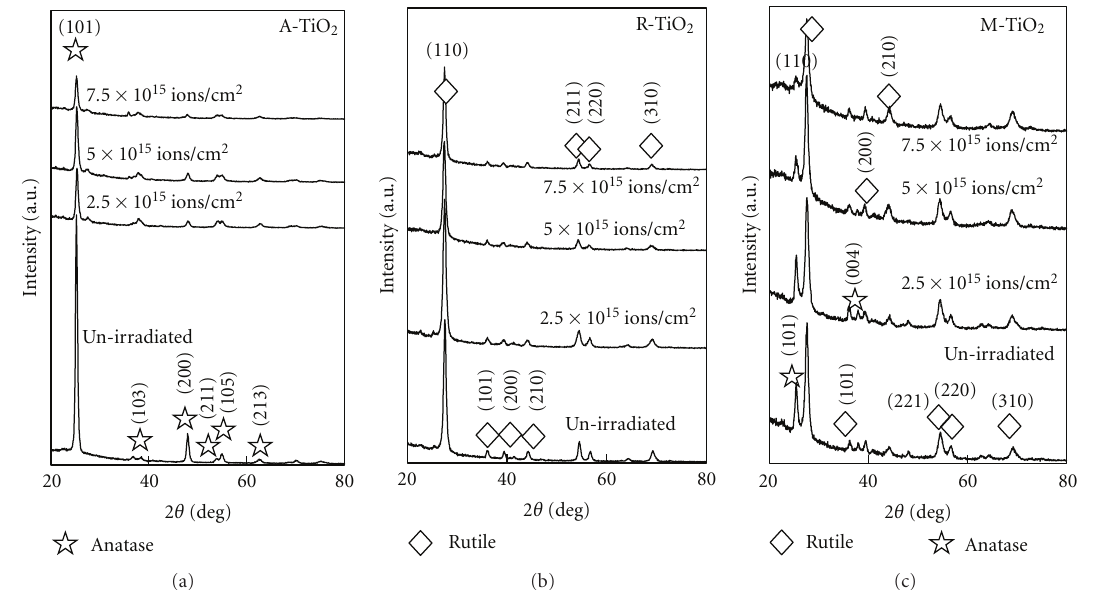
Figure 3: XRD patterns of the unirradiated A-, R-, and M-TiO 2 thin film and the irradiated A-, R-, and M-TiO 2 thin film with an N + ion dose of 2.5 × 10 15 , 5.0 × 10 15 , and 7.5 × 10 15 ions/cm 2